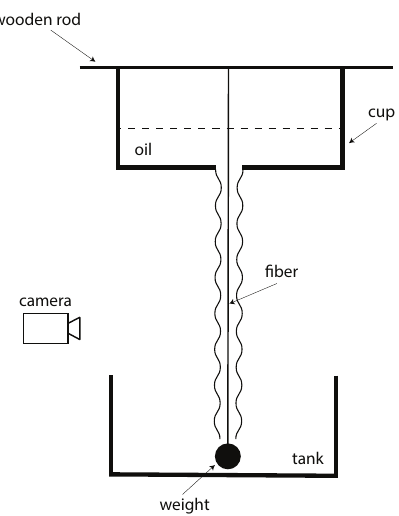
Figure 6. Experimental setup